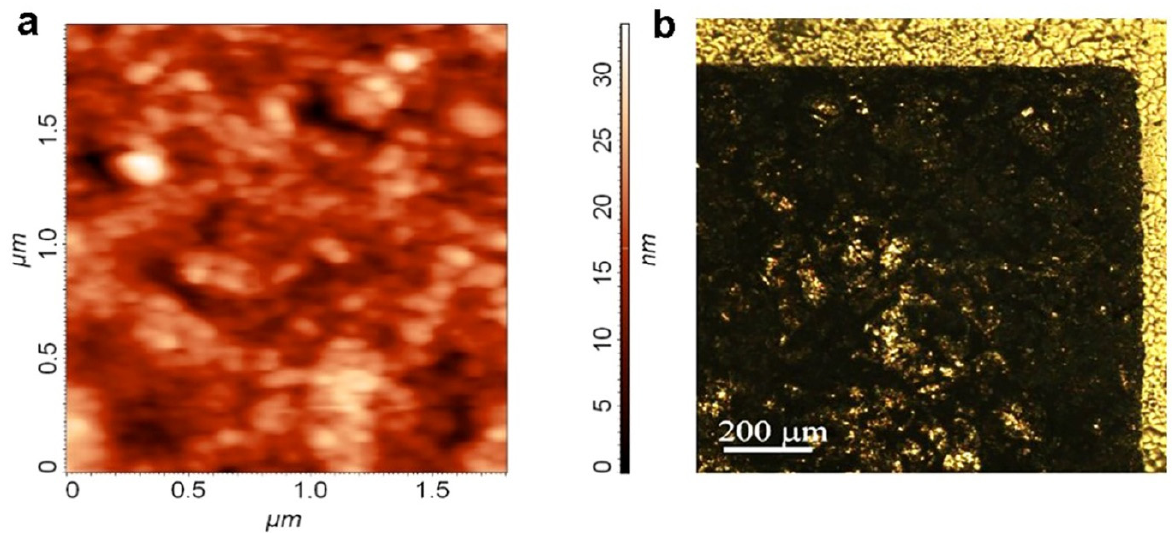
Figure 2 . ( a ) An atomic force microscope image of a layer created by screen printing from a gra- phene suspension. ( b ) Optical image of the graphene suspension strip edge screen-printed onto Kodak photographic paper.